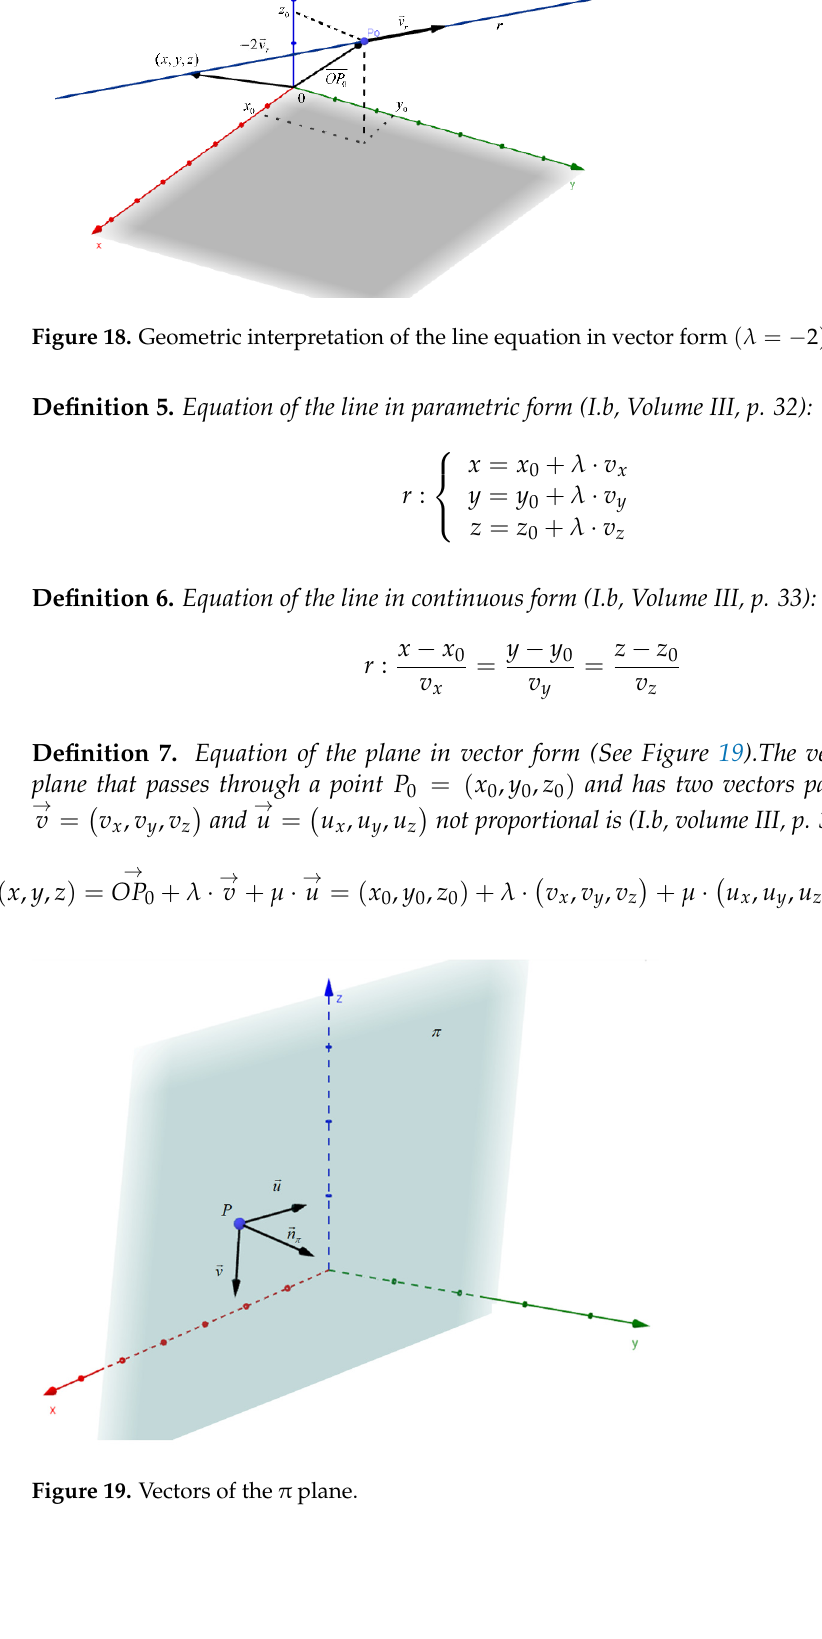
(10) . Figure 17. Geometric interpretation of the mixed product of three vectors. •